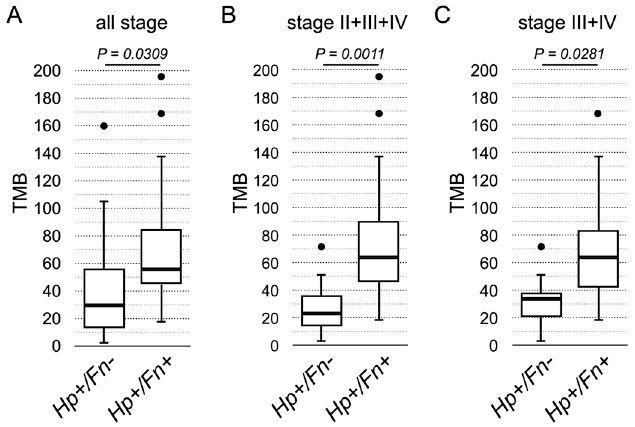
Figure 4. The statistical analysis of TMB between the F. nucleatum ‐ positive and F. nucleatum ‐ negative specimens. ( A ) All specimens of all stages were included for analysis (Fn ‐ group n = 20, Fn+ group n = 16). ( B ) Specimens of stages 2 to 4 were included for analysis (Fn ‐ group n = 12, Fn+ group n = 13). ( C ) Specimens of stages 3 and 4 were included for analysis (Fn ‐ group n = 9, Fn+ group n = 10).